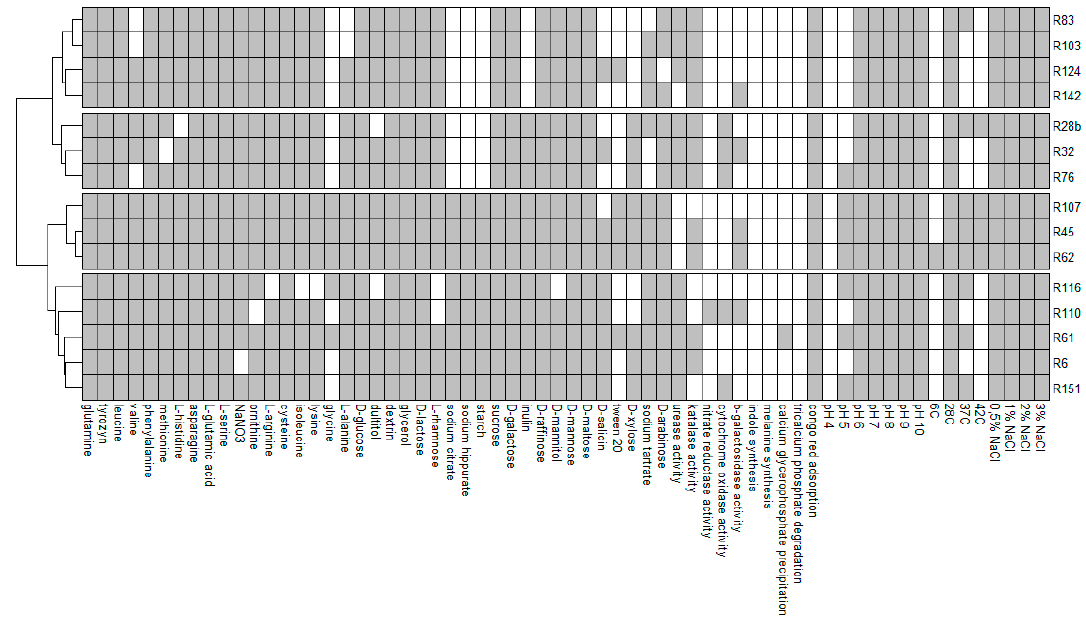
Figure 3. The heatmap showing results of the phenotyping test (grey—growth in selected conditions, white—lack of growth).